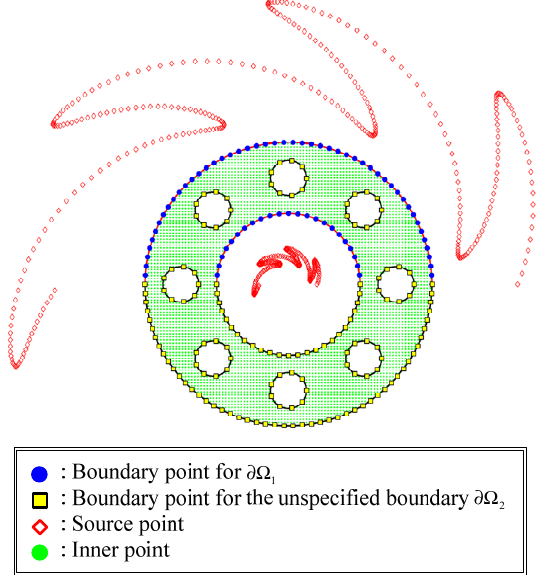
Figure 7. Location of the collocation points for Example 1.